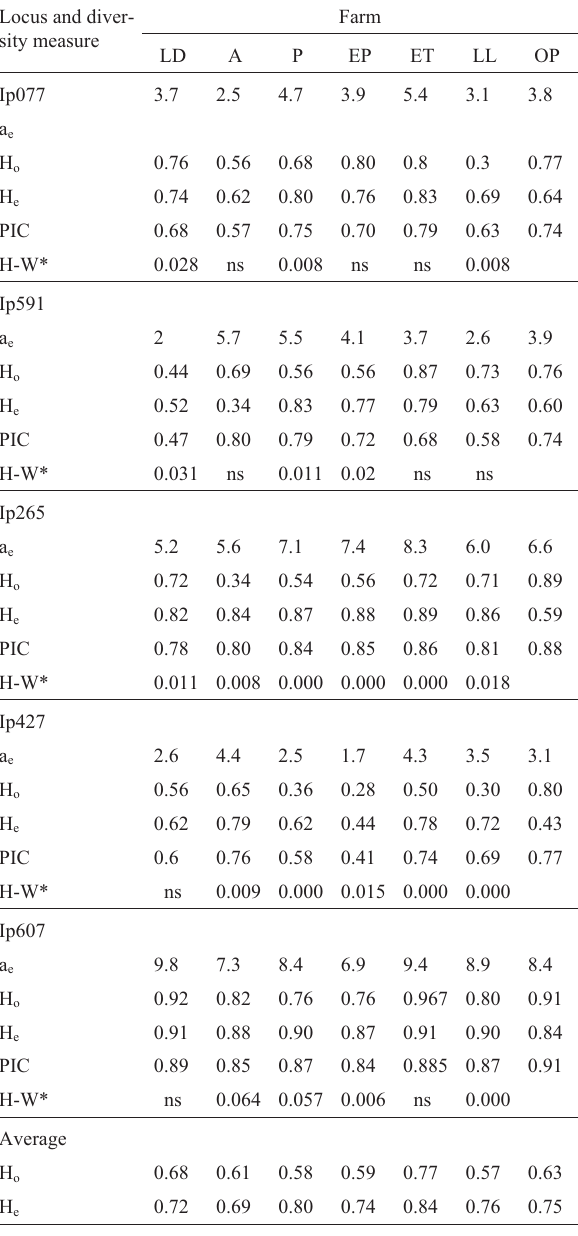
Table 1 - Effective number of alleles (ae), expected and observed hetero- zygosity (He and Ho respectively), polymorphic information content (PIC) and Hardy-Weinberg values (HW) of five microsatellite markers used in six catfish farms in the Mexican state of Tamaulipas, the farms be- ing: Las Delicias (LA), Acuamex (A), Prodatec (P), El Paraìso (EP), El Tomaseño (ET) and La Lajilla (LL). Locus and diver- sity